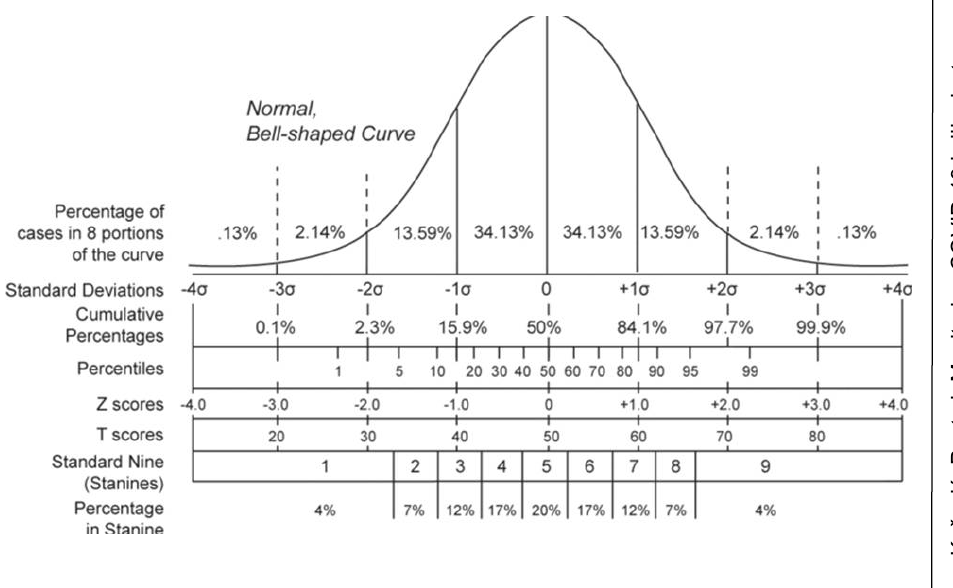
Figure 5 – Gaussian distribution extended to 8